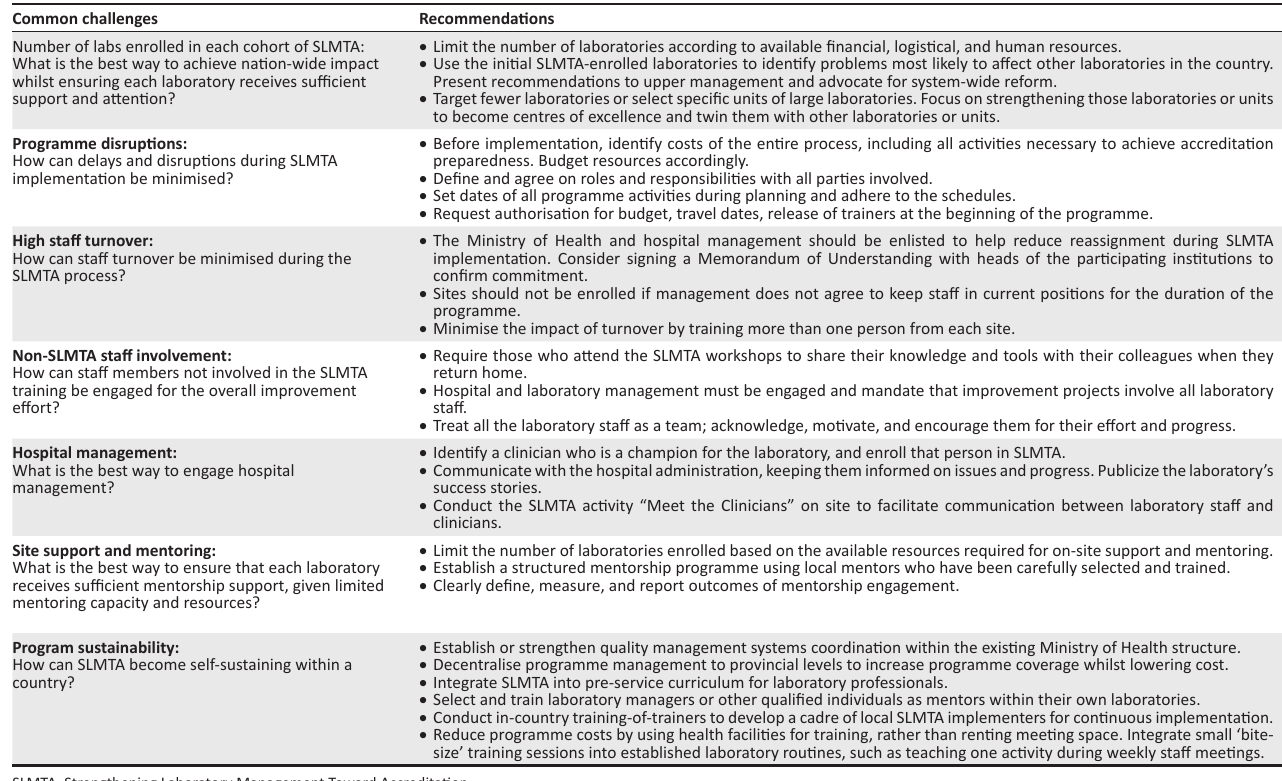
TABLE 2: Common challenges and recommendations for SLMTA